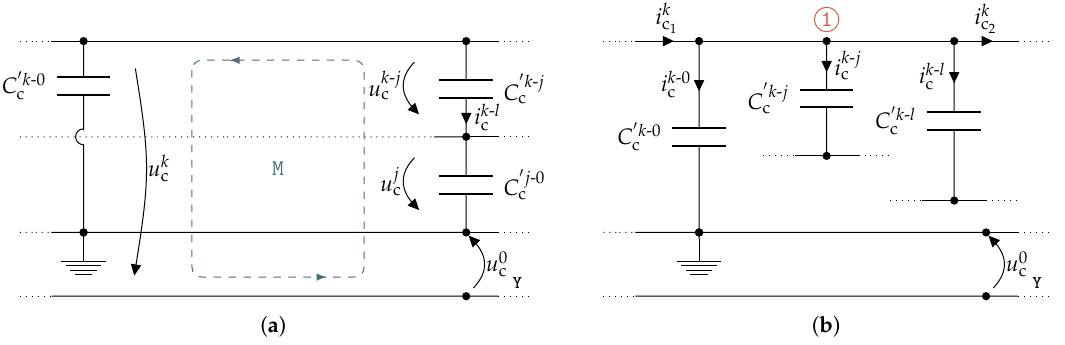
Figure A1. Isolated capacitance network of the π - and τ -cable equivalent circuits: ( a ) Voltage mesh for phase k over phase j to ground, j , k